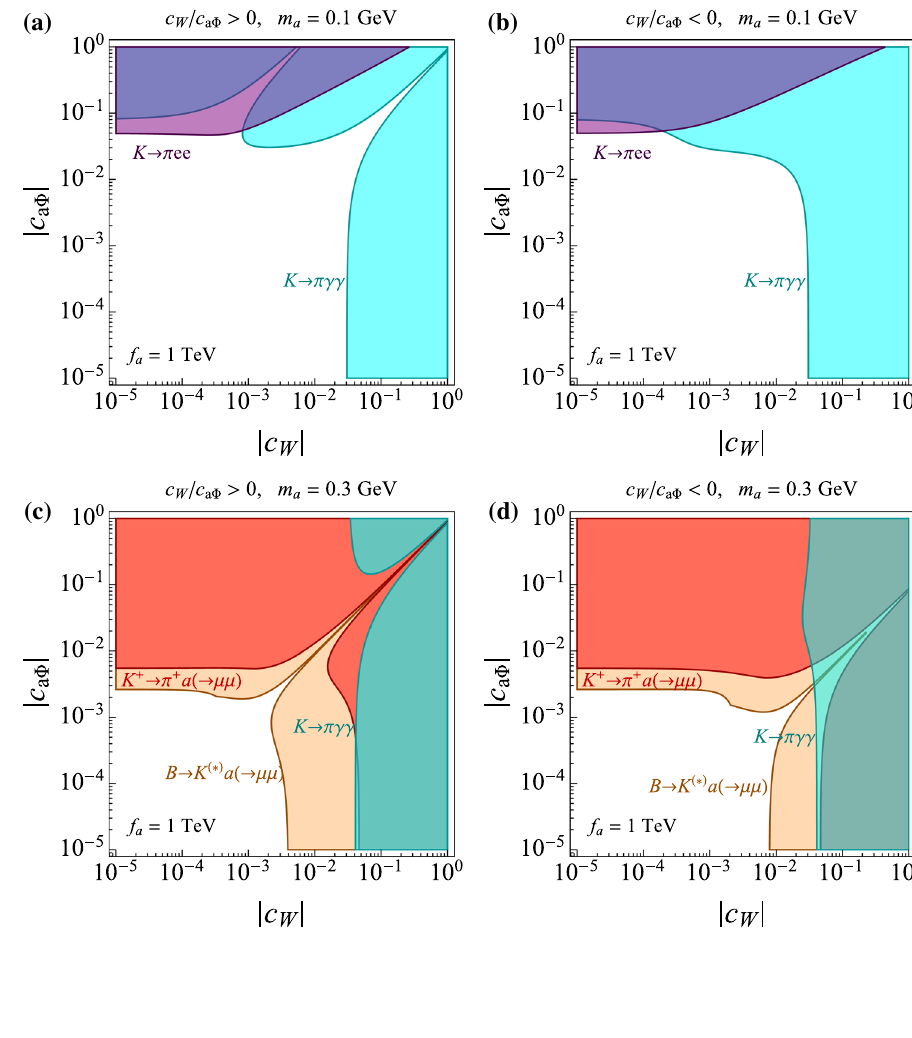
[77], B ( B s → μμ) (blue) [81,82], B ( K → π ee ) (purple) [77] and B ( K → πγγ) (cyan) [78]. The grey dashed lines are projections for the SHiP experiment [40]. The unconstrained regions in the range of the LHCb bounds correspond to the masses of several hadronic resonances which are vetoed in their analysis